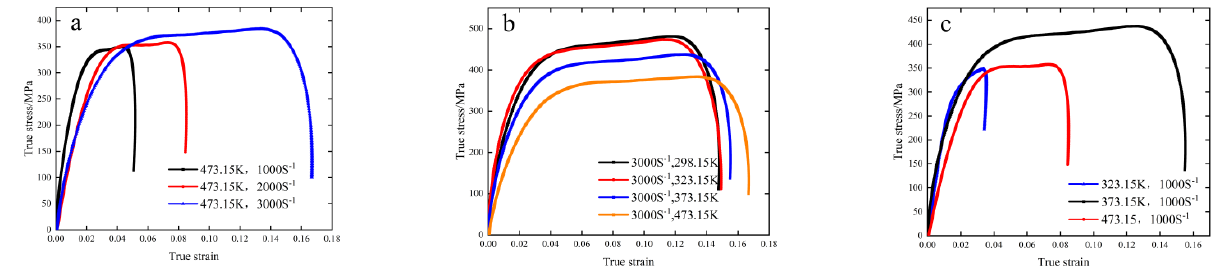
Figure 3. Real stress–strain curves under different test conditions. ( a ) 473.15 K. ( b ) 3000 S − 1 . ( c ) 1000 S − 1 .